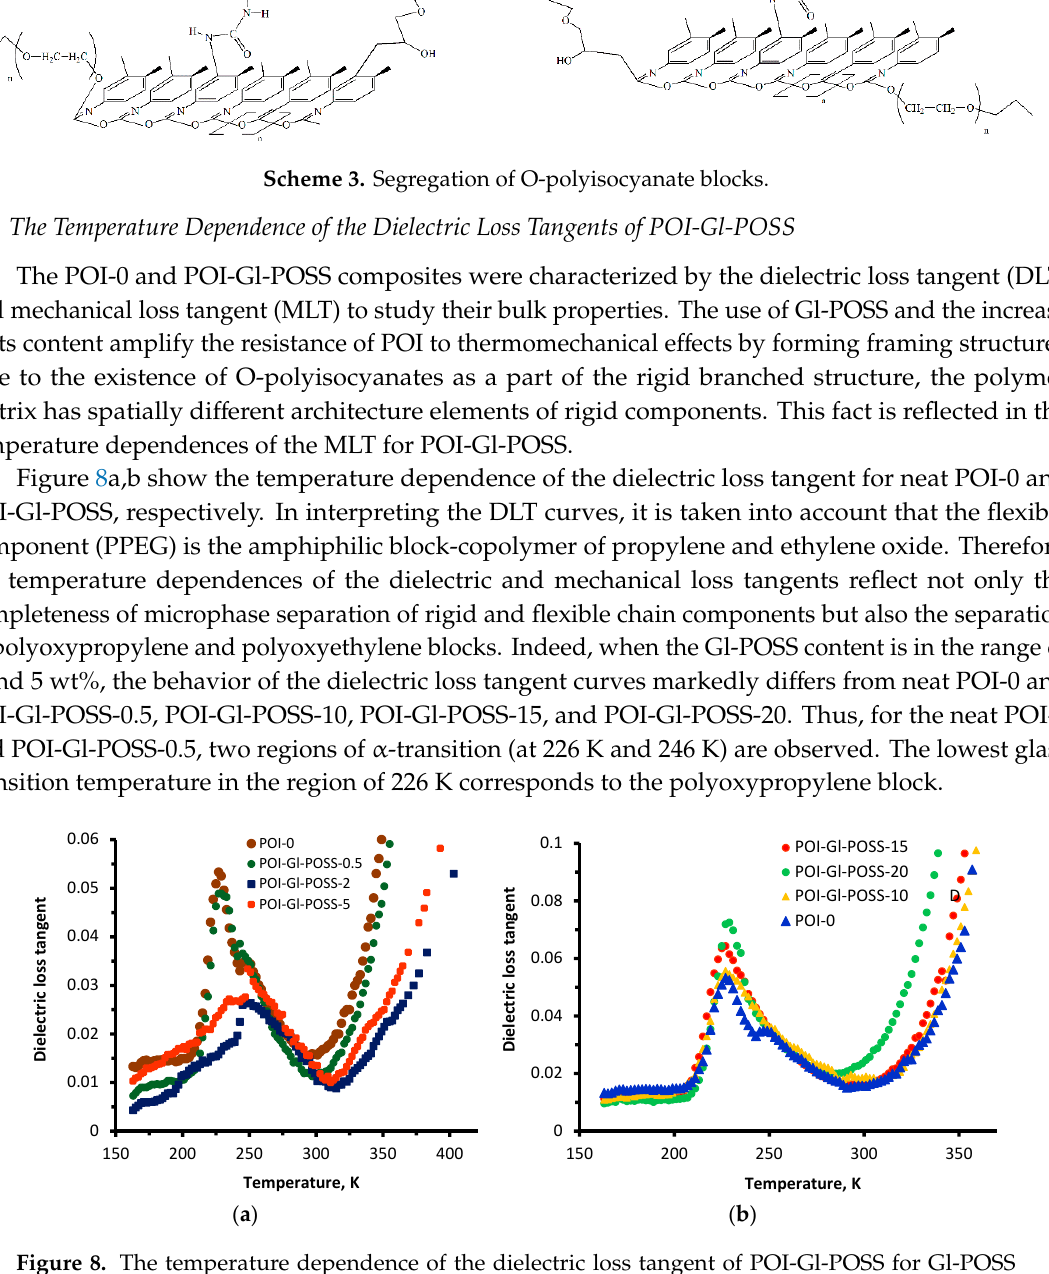
Figure 8. The temperature dependence of the dielectric loss tangent of POI-Gl-POSS for Gl-POSS content up to 5 wt% ( a ) and for Gl-POSS content from 10 to 15 wt% ( b ).